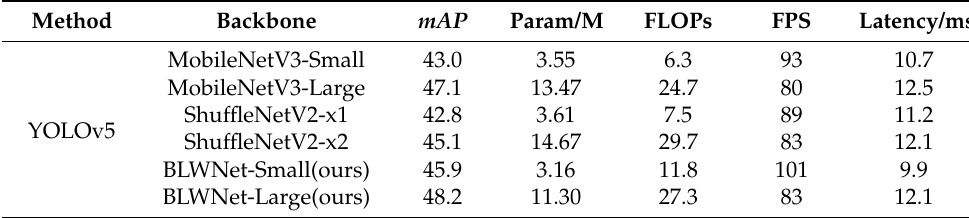
Table 5. Comparison of different lightweight networks as backbone networks.